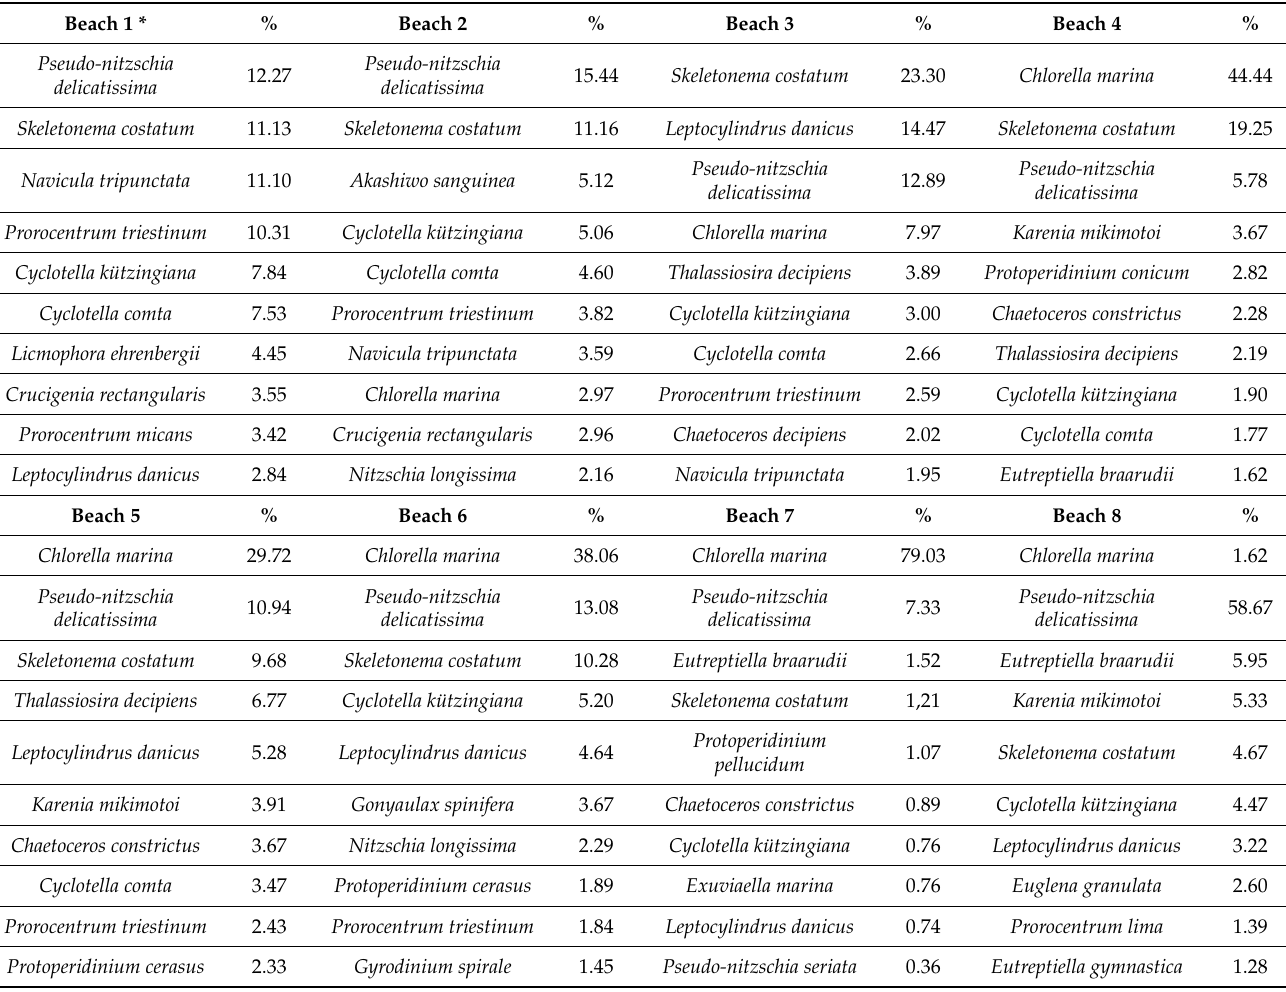
Table 4. Top 10 most-abundant phytoplankton species in each beach and their percentage to the total phytoplankton density. Beach 1